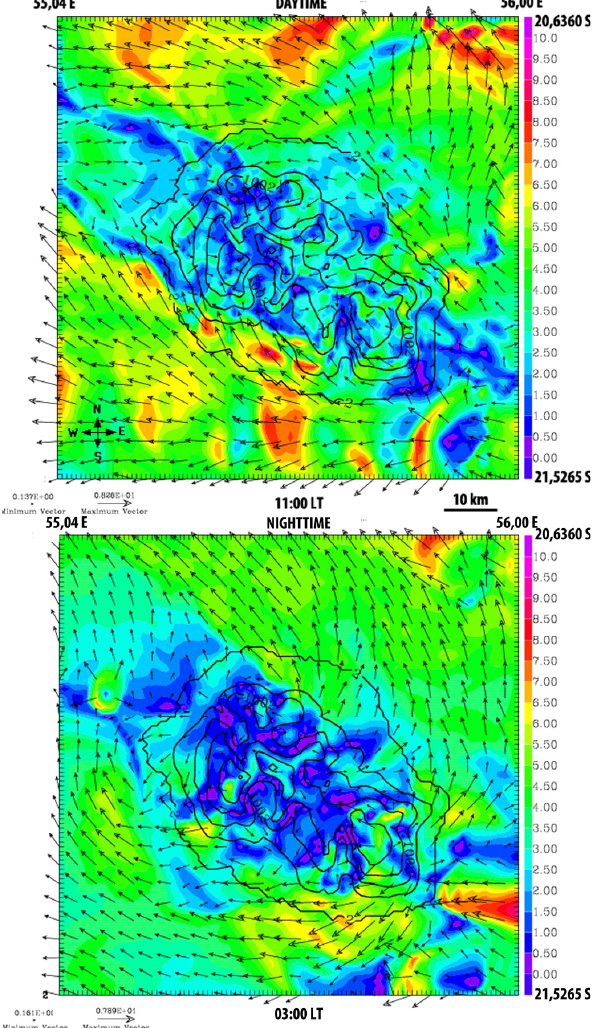
Fig. 6. Simulation ALIZ5 – wind speed (color scale) and vectors at the first model level above the ground, at 11:00LT (top) and 03:00LT